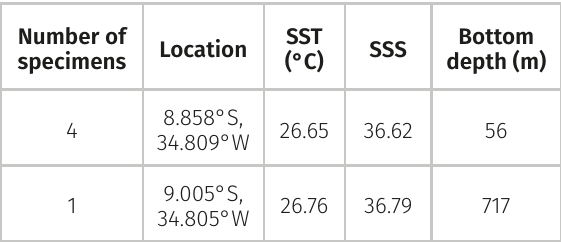
Table I. Teissiera polypofera occurrences off northeast